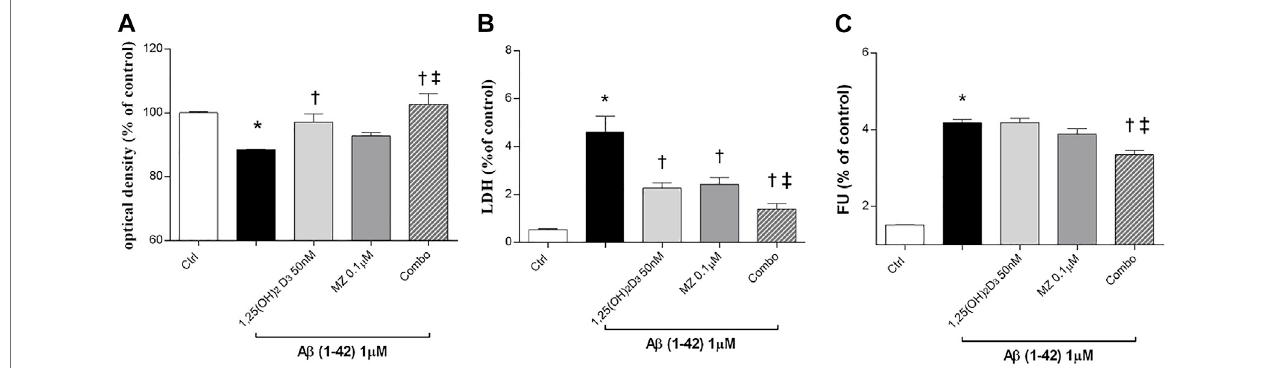
FIGURE 1 | 1,25(OH) 2 D 3 , meso-zeaxanthin (MZ), and their combination show protective effect in ARPE-19 cells treated with A β (1 – 42). Cells were pretreated for 24 h with tested compounds and for 48 h with A β insult. At the end of treatment were carried out MTT (A) , LDH (B) , and the ROS assay (C) . Values are reported as mean ± SD( n (cid:2) 5).Datawereanalyzed byone-wayANOVA and Tukey ’ sposthoctest formultiplecomparisons.*p < 0.05vs. control; † p < 0.05vs. A β , ‡ p < 0.05 vs.50 nM 1,25(OH) 2 D 3 or 0.1 µM MZ.